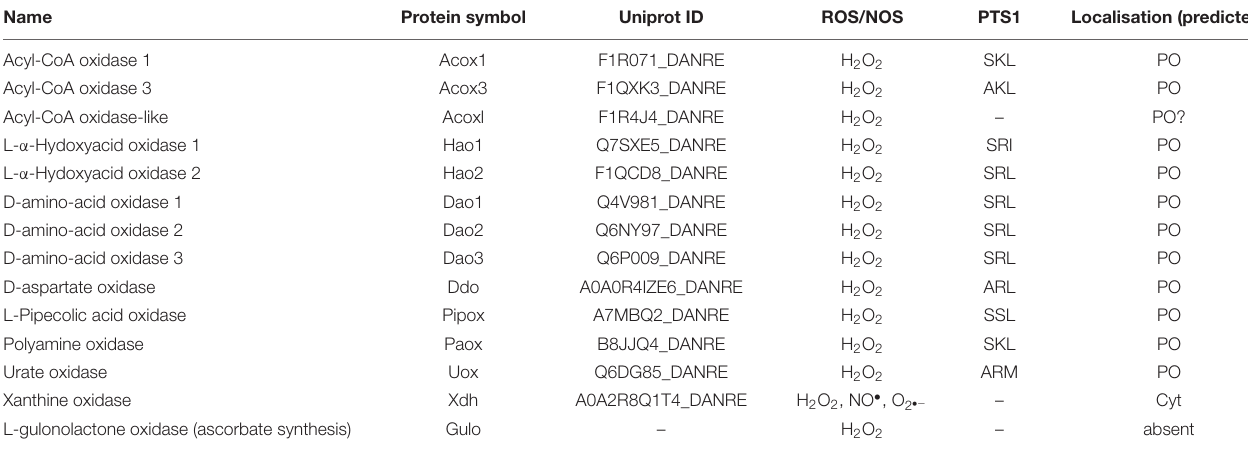
TABLE 2 | Candidate peroxisomal oxidases in